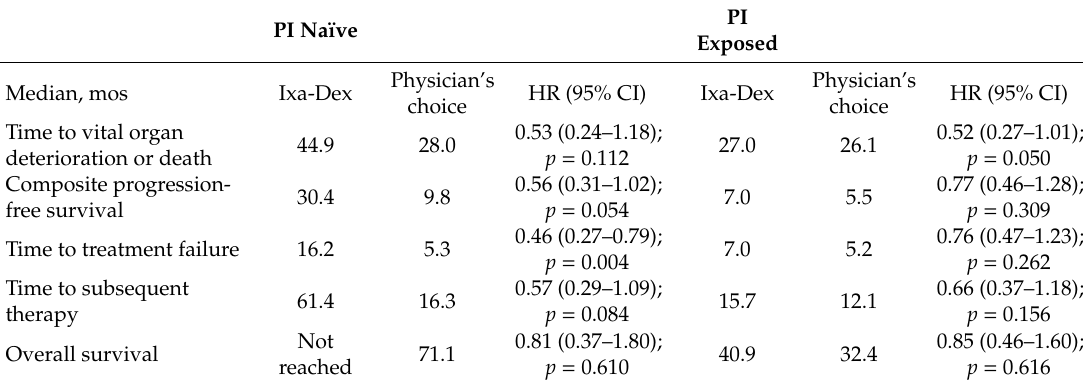
Table6. Time-to-eventoutcomesforpatientswithALamyloidosistreatedwithIxa-Dexvs.